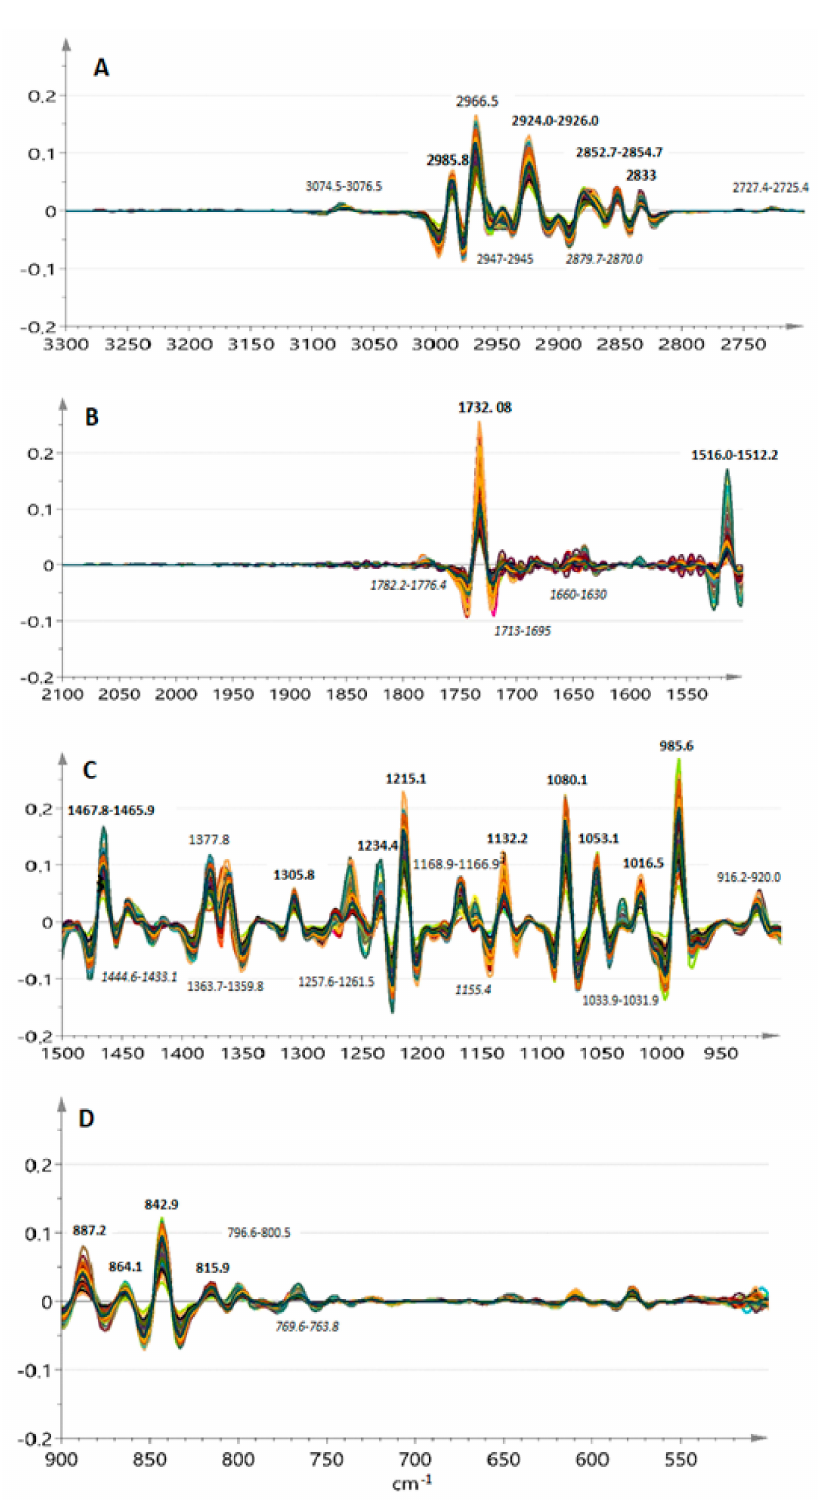
Figure 1. Inverse 2nd order derivative FT-IR transmittance spectra of the reference bay laurel leaf essential oil (EO) samples ( n = 97); 3300–2700 cm − 1 ( A ); 2100–1500 cm − 1 ( B ); 1500–900 cm − 1 ( C ); 900–500 cm − 1 ( D ). Peaks shifted by more than ± 2 cm − 1 are shown in